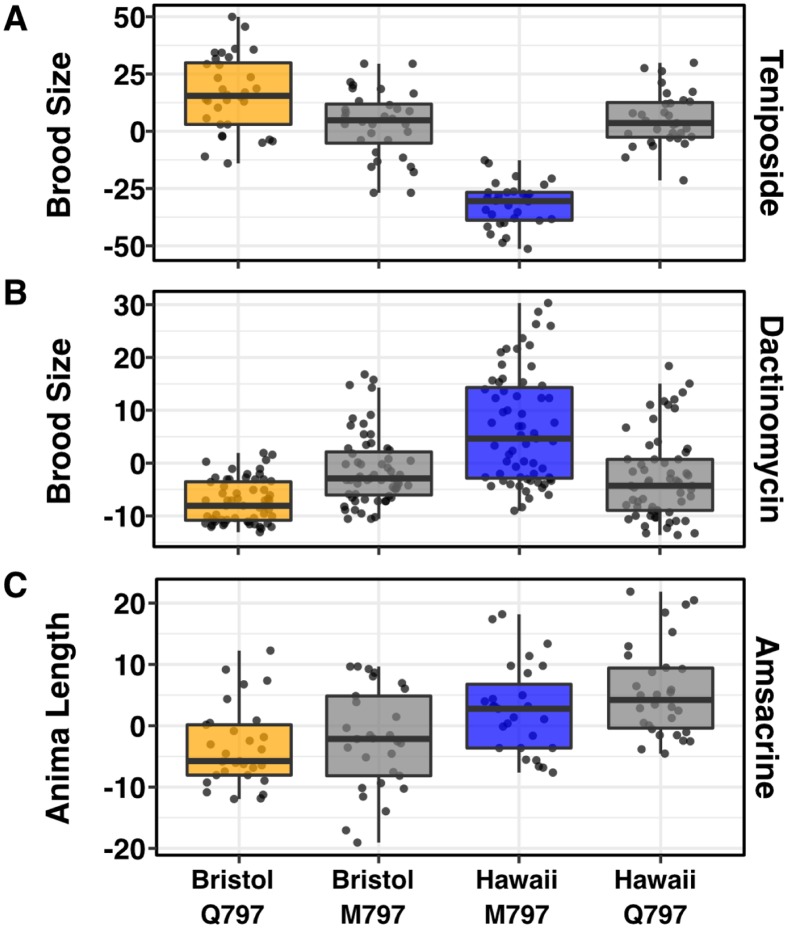
Variation in the TOP-2 797 allele underlies response to multiple topoisomerase II poisons.Tukey box plots of (A) regressed brood size in response to teniposide. Mean phenotypes of the Bristol and Hawaiian allele swap strains are significantly different from the Bristol and Hawaiin parental strains (Tukey’s HSD, Bristol—Bristol Swap p-value = 0.0009; Hawaii—Hawaiian Swap p-value < 1E-7). (B) Tukey box plots of regressed brood size in response to dactinomycin. Mean phenotypes of the Bristol and Hawaiian allele swap strains are significantly different from the Bristol and Hawaiin parental strains (Tukey’s HSD, Bristol—Bristol Swap p-value = 0.0002; Hawaii—Hawaiian Swap p-value = 3E-7). (C) Tukey box plots of regressed animal length in response to amsacrine show allele swap strains are not significantly different from parental strains (Tukey’s HSD, Bristol—Bristol Swap p-value = 0.925; Hawaii—Hawaiian Swap p-value = 0.414). Orange corresponds to the Bristol genetic background and blue to the Hawaii background. Labels correspond to the genetic background and the corresponding residue at position 797 of TOP-2 (Q for glutamine, M for methionine).